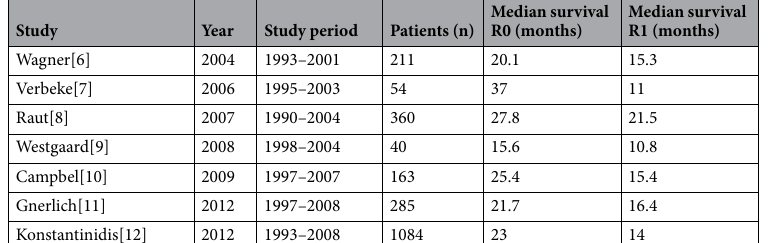
Table 1. Comparison of median survival for R0 and R1 resections.